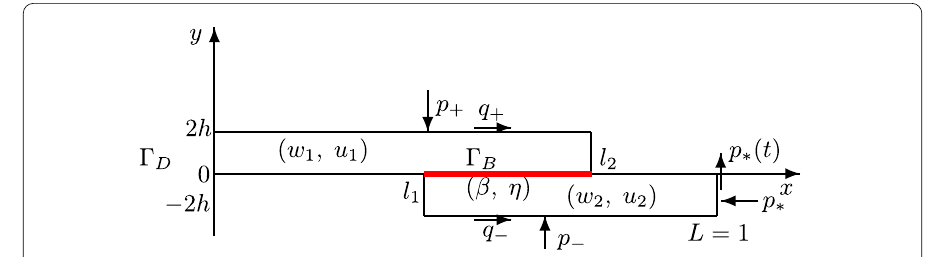
Figure 1 Two 2D-bars in adhesive contact. The adhesive (red) occupies the interval l 1 ≤ x ≤ l 2 ( y = 0) where the functions β , the bonding field, and η , the humidity density function, are